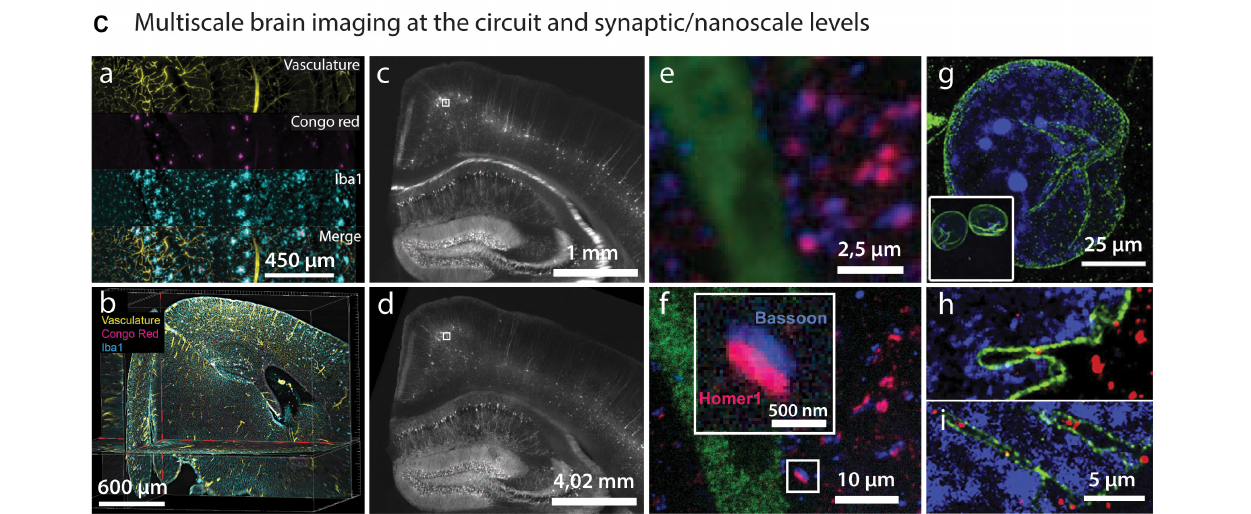
FIGURE 1 | Brain tissue clearing and expansion approaches for neuropathological imaging. (A) Common steps required for whole-brain tissue clearing, imaging, and analysis of neuropathological features, allowing CNS-wide identification of vulnerable circuits and cell types. (B) Tissue expansion approaches can be used to study early pathological alterations caused by abnormal protein conformation, aggregation, and subsequent ultrastructural changes in specific subcellular compartments and organelles within affected cell types and circuits identified using tissue clearing. (C) Diffraction-limited light microscopy of cleared brain tissue allows imaging of large brain circuits at cellular resolution (a–c) , including analysis of neuropathological markers (a,b) , but it does not reach synaptic nanoscale resolution in non-expanded tissues (e) . On the contrary, expansion microscopy of tissues and cells (d,f-i) allows nanoscale imaging using diffraction-limited microscopes, enabling detailed visualization of synapses (e) and other subcellular structures such as nuclear envelope invaginations (g–i) in healthy (h) and ALS pathological conditions (i) . (a,b) LSFM images showing individual channels (a) and orthogonal optical planes (b) of a cleared transgenic AD mouse brain